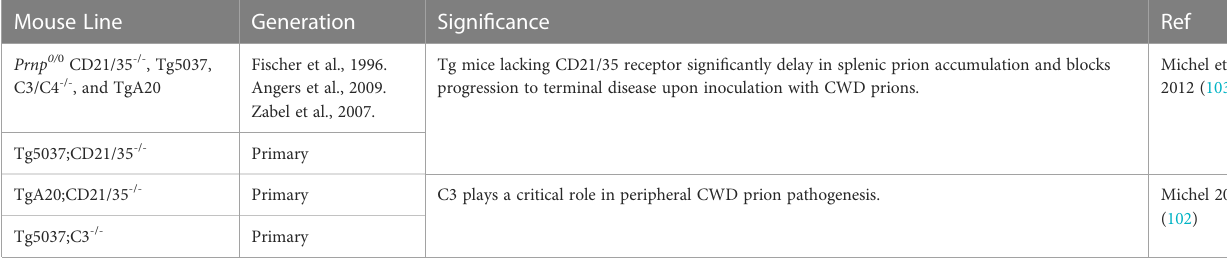
TABLE 7 Investigation of transmission in regard to immune system mediators. Mouse Line